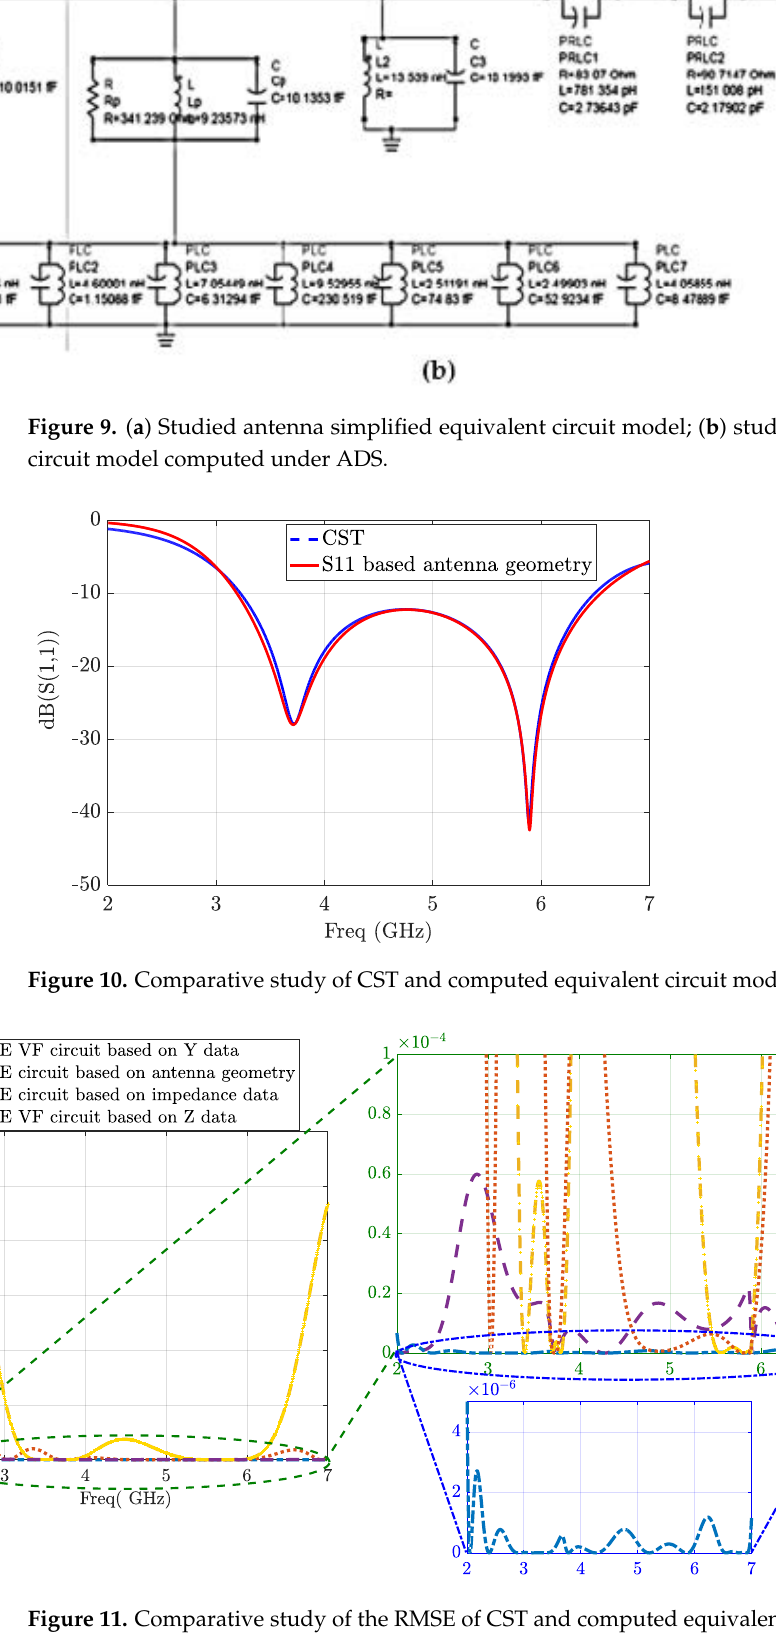
Figure 11 . Comparative study of the RMSE of CST and computed equivalent circuit model results. 2.4. Prototype, Measurement and Comparison The prototype of the studied antenna and experimental setup using a Ceyear 3656D VNA are shown in Figure 12.